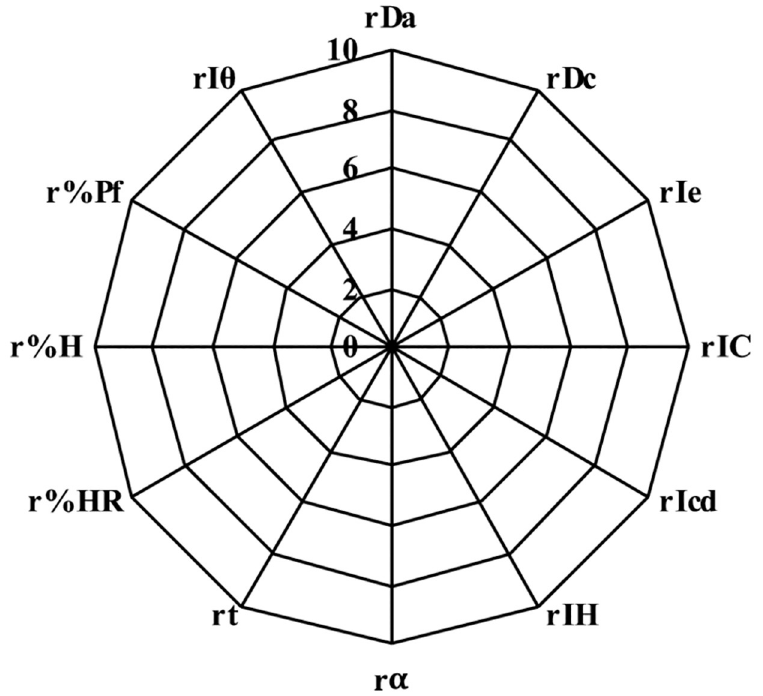
Fig 3. SeDeM diagram for the calculated parameters